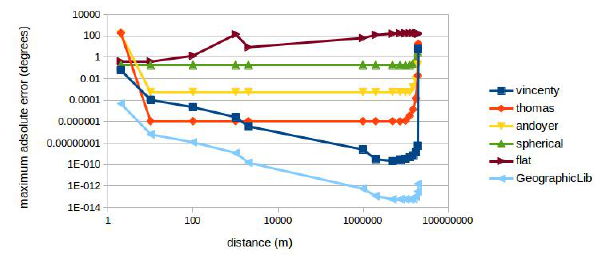
Figure 2. The maximum absolute azimuth error as a function of